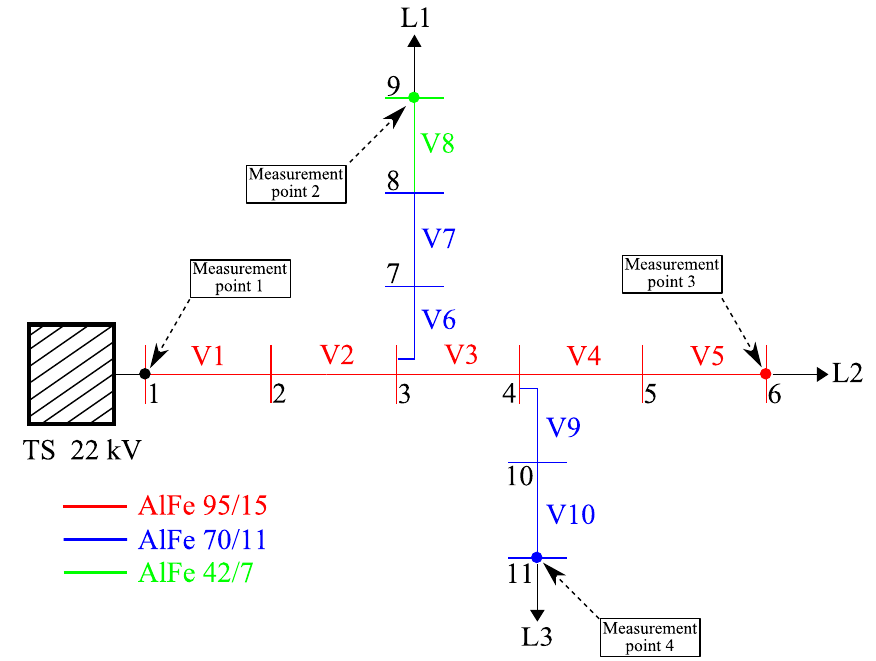
Figure 27. The scheme of measured and modelled distribution grid.